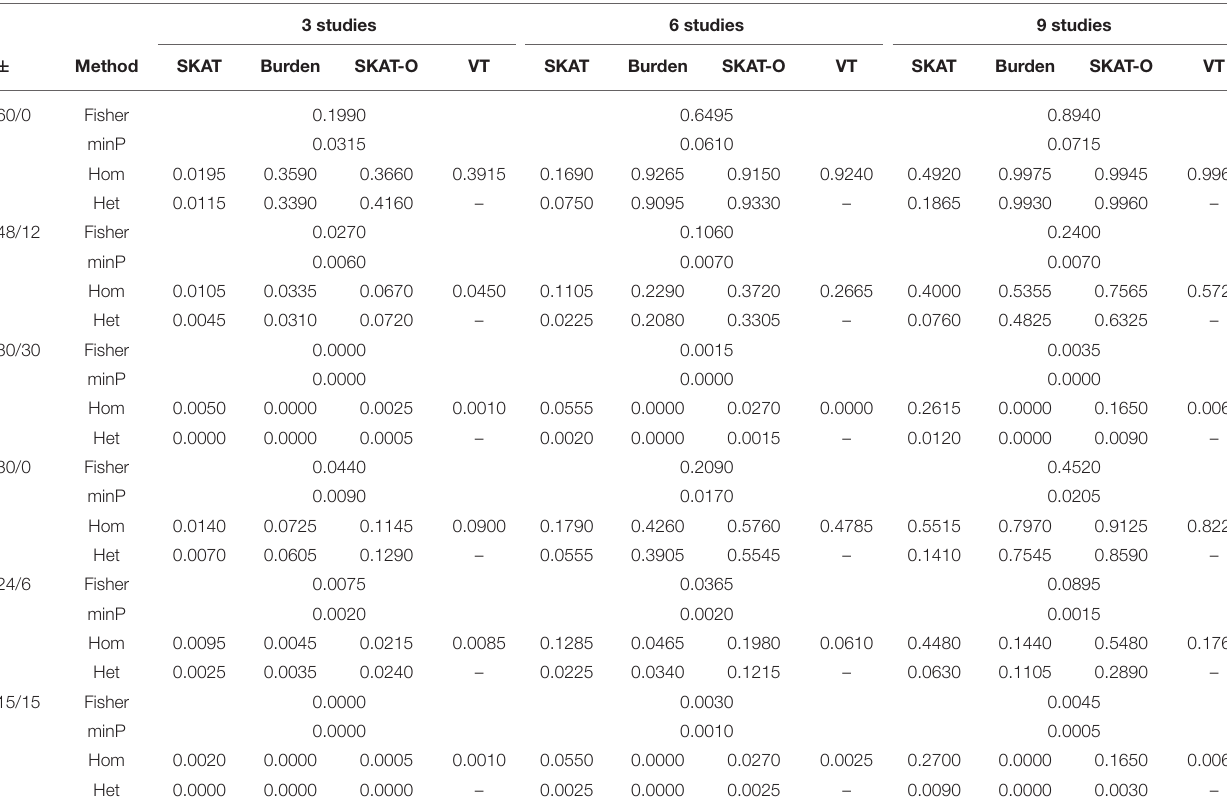
TABLE 2 | Empirical power estimates for dichotomous phenotype for homogeneous variants among